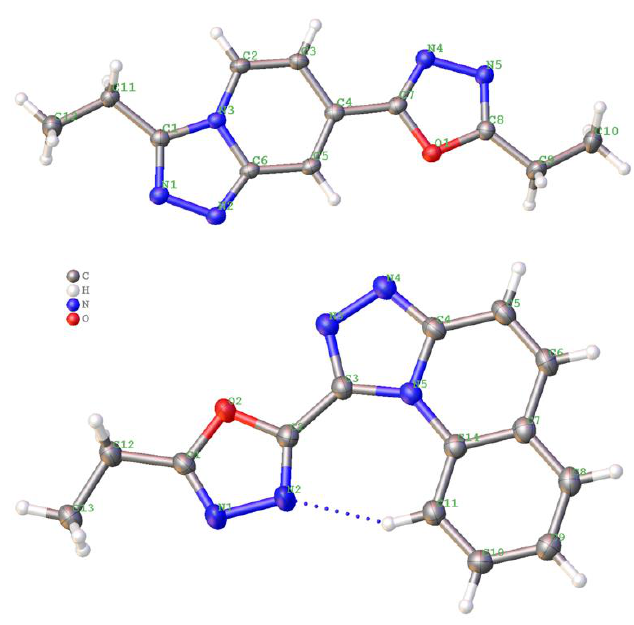
Figure 1. ORTEP drawing of X-ray structures of (2-ethyl-5-(3-ethyl-[1,2,4]triazolo[4,3- a ]pyridin-6- yl)-1,3,4-oxadiazole) ( 3ba , CCDC #2092596) and